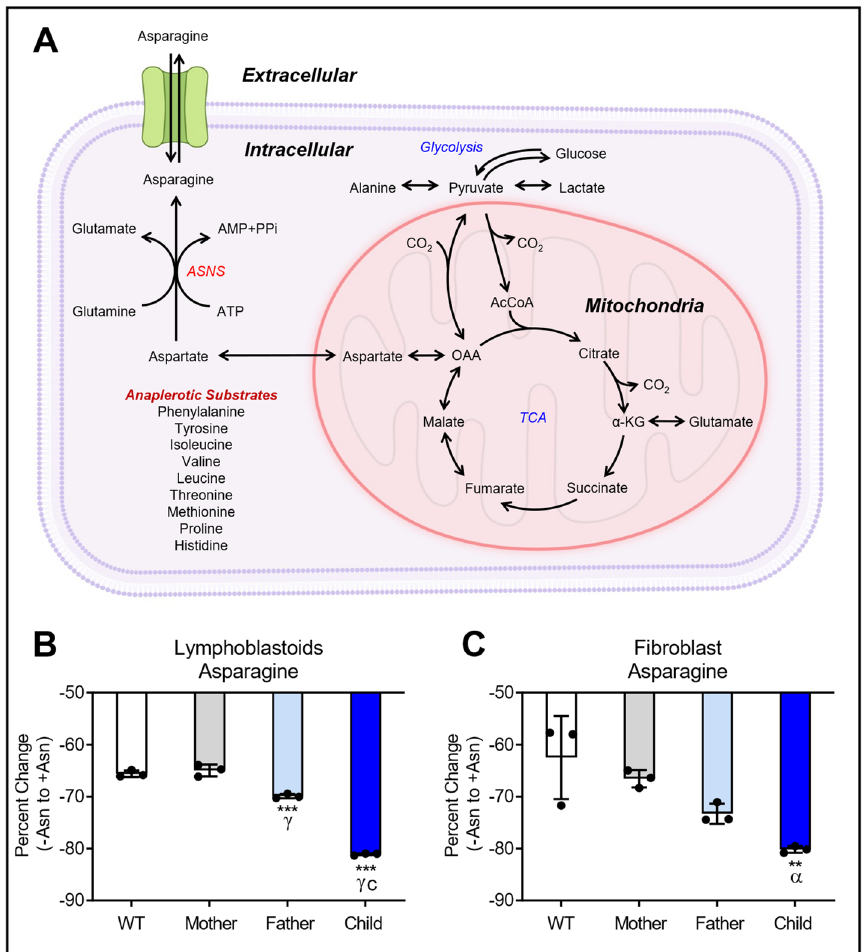
Figure 1. Intracellular analyses of asparagine (Asn) content of cells derived from two separate families carrying unique mutations in the ASNS gene. Panel ( A ) presents the ASNS reaction schematic of Asn production along with central metabolic pathways. Panel ( B ) shows the percent change of intracellular Asn measured in LCL cells generated from the first family. Panel ( C ) illustrates the percent change of intracellular Asn in the fibroblasts from the second family. Percent change is reported as the change of Asn content from − Asn to +Asn media conditions. Since Asn decreased in − Asn conditions, the percent change values are reported as negative. Intracellular Asn content was measured by targeted GC-MS analysis. All cell lines were tested as N = 3 biological replicates. The data are shown as the means ± SD. Statistical significance was established by ANOVA with Tukey post-hoc analysis and is represented as: (**) if p ≤ 0.01 and (***) if p ≤ 0.001 compared to WT. ( α ) if p ≤ 0.05 and ( γ ) if p ≤ 0.001 compared to Mother. (c) if p ≤ 0.001 compared to Father.